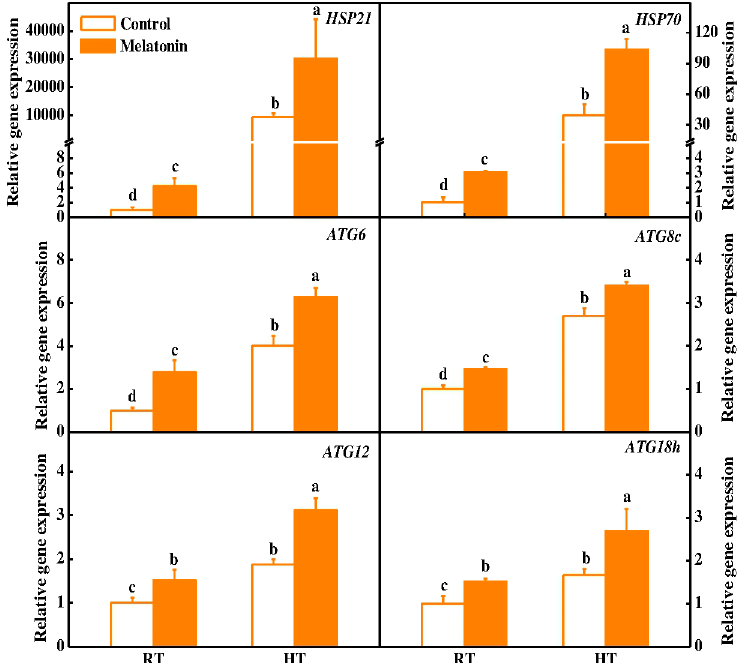
Figure 6. Expression of HSP and ATG genes in tomato anthers after 3 h high temperature stress. The data shown are the average of four replicates, with the standard errors shown by vertical bars. Means denoted by the same letter did not significantly differ at p < 0.05, according to Tukey’s test.